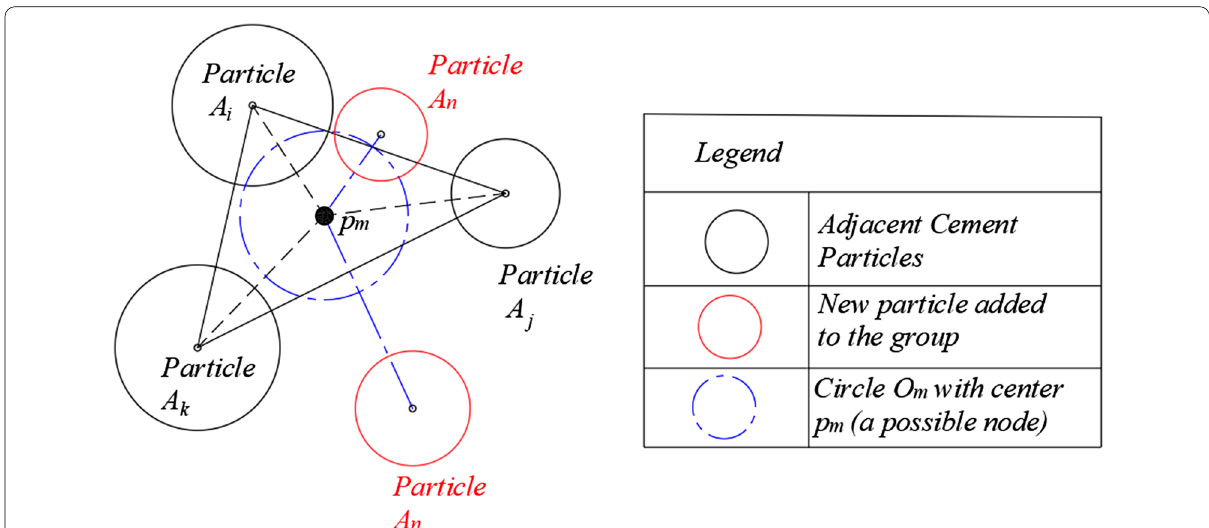
Fig. 5 Schematic diagram for the judgment of new particle placement in weighted Voronoi diagram.